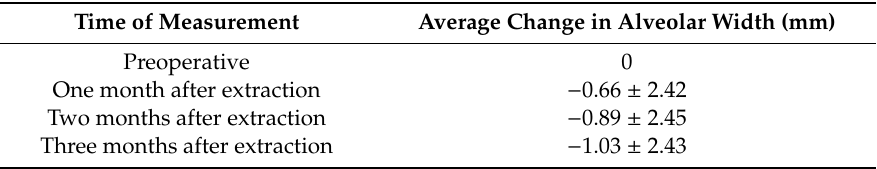
Table 2. Variation in alveolar width variation by time of